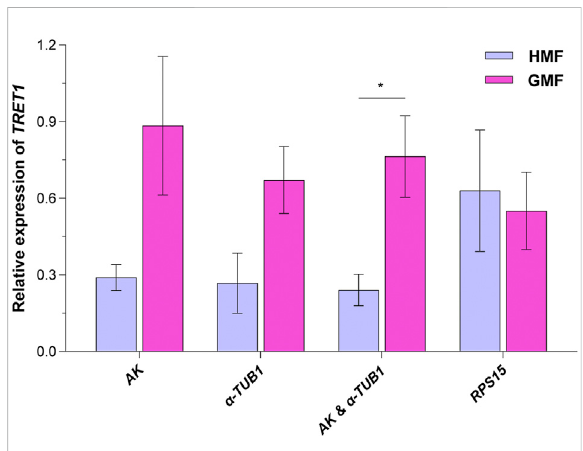
FIGURE 6 The transcript expression analyses for TRET1 in 2-day-old brachypterous females normalized to the reference genes evaluated in this work. The top two stable candidate reference genes AK and α -TUB1 (individuallyor incombinationuse)and the least stable candidate reference gene RPS15 were picked for the validation assay under the hypomagnetic fi eld (HMF) versus local geomagnetic fi eld (GMF). Samples of four biologically independent pools were used. The columns represent averages with vertical bars indicating standard errors. Asterisk (*) denotes signi fi cant differences between theHMF versuslocal GMF by one- way ANOVA at p <